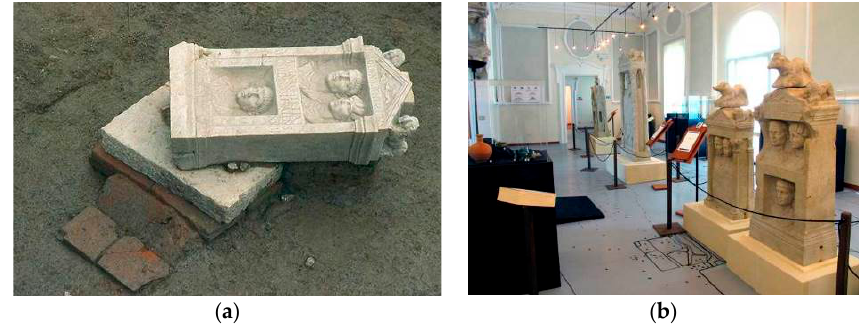
Figure 3. Evidence of the archeological interest in Gambulaga, Portomaggiore (FE, Italy): ( a ) Artifacts found via excavation of the Fadieni necropolis site http://www.archeobo.arti.beniculturali.it/mostre/ settimana_cultura_06.htm; ( b ) Permanent exhibition of the artifacts found at the castle, Delizia del Verginese http://www.archeobologna.beniculturali.it/mostre/gambulaga.htm.